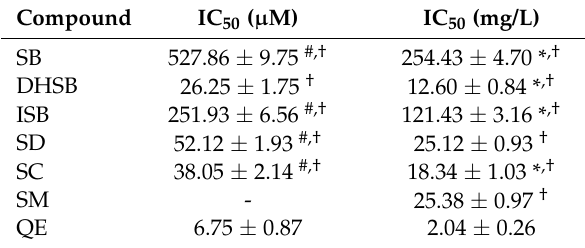
Table 2. DPPH scavenging activity of silymarin and